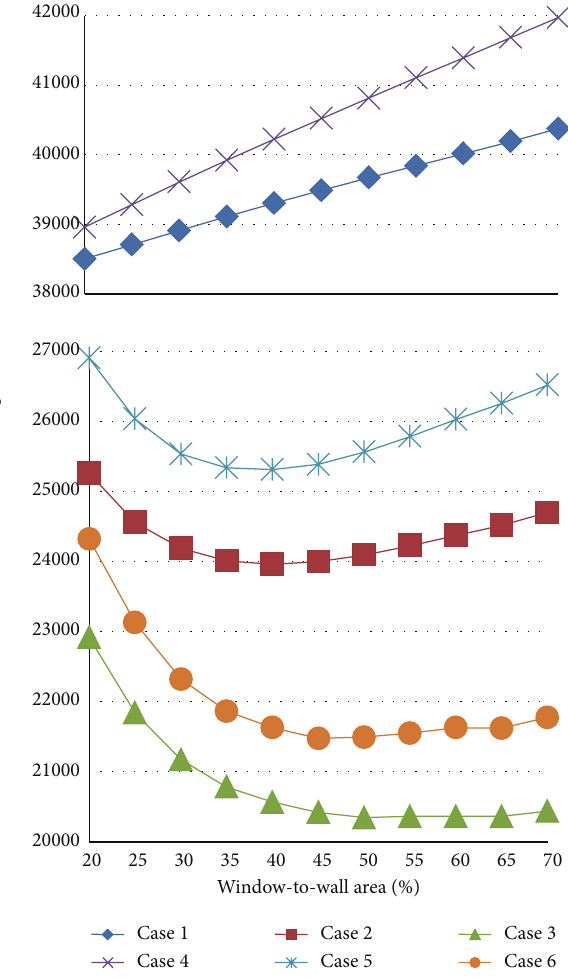
Figure 5: Results for cases